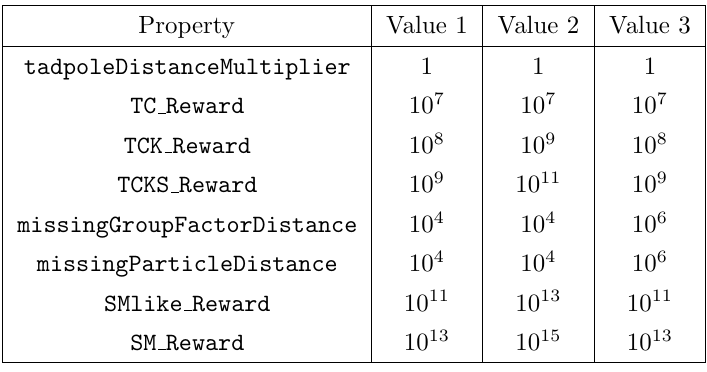
Table 3 . Value assignments the CONSISTENCY-SM reward